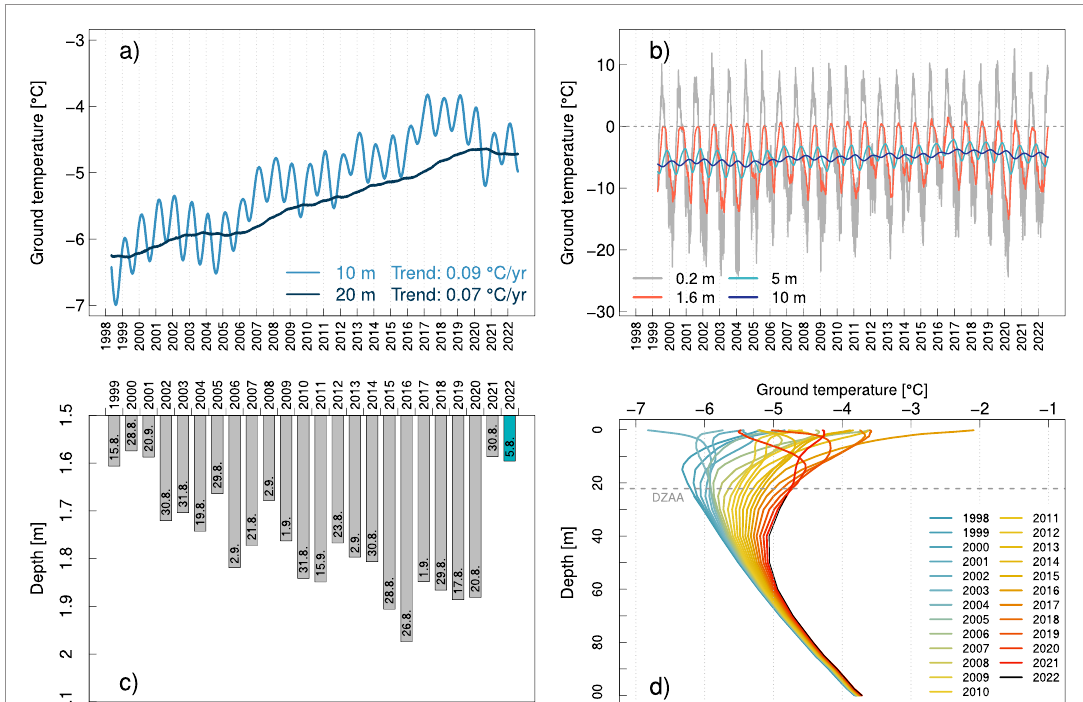
Figure 2. Long-term trends of ground temperature at Janssonhaugen for the years 1998–2022: long-term changes in permafrost thermal state at 10 and 20 m depth (a); daily time series of ground temperature at 0.2, 1.6, 5 and 10 m depth (b); maximum annual depth of the 0 ◦ C isotherm and the corresponding day (c); mean annual ground temperature profiles and mean depth of DZAA (d). Time series for 2022 includes data until 5 August